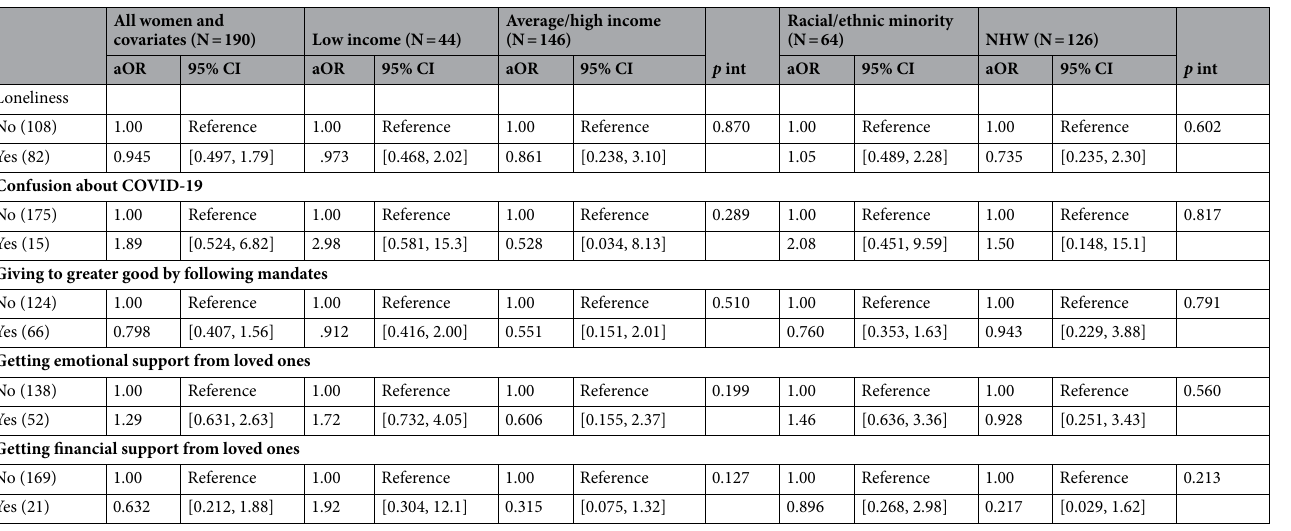
Table 2. Adjusted odds ratios (aOR) and 95% confidence intervals (CI) for the association between COVID- 19 experiences and odds of high anxiety among BRCA1/2 -positive women from disadvantaged health populations, overall and by income status and race/ethnicity. Missing values: anxiety (15), change in life due to COVID-19 (15), age (3), and cancer status (3). Bold font indicates statistically significant with corresponding p < 0.02. p interaction terms are between income status, racial/ethnic minority status, and predictor(s). Covariates/stratifications: age (continuous), number of comorbid conditions (continuous), years since genetic testing (continuous), education (some college or less, college graduate or above), marital status (married/ living as married, other), cancer status (no cancer history, cancer history), income status (average/high income, low income), geographic location (urban/suburban, rural), and race/ethnicity (non-Hispanic white [NHW], Hispanic or racial